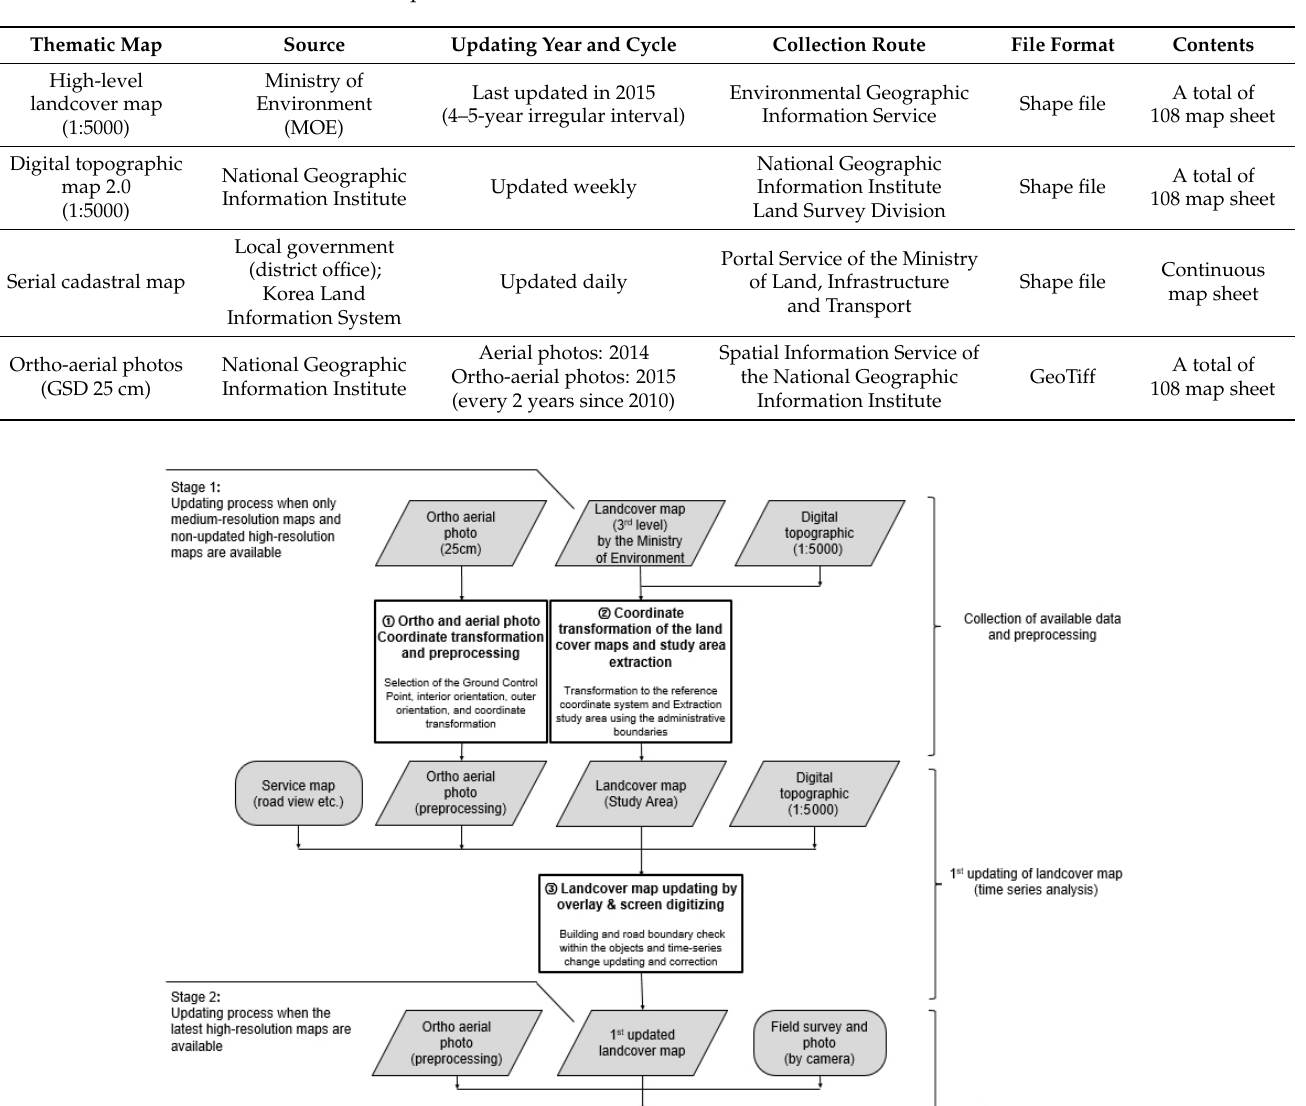
Table 1. Spatial data collection record.